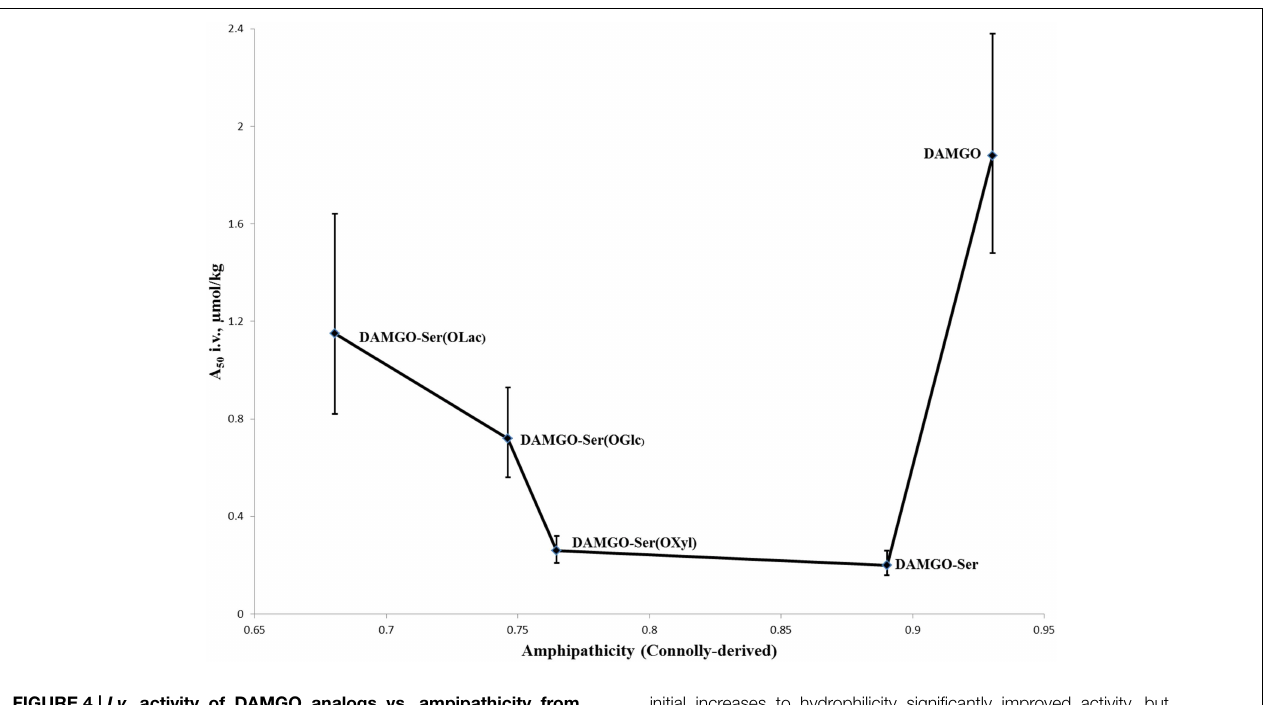
initial increases to hydrophilicity significantly improved activity, but subsequent increases led to a decrease. This is believed to be the result of the peptides spending a preponderance of time in the aqueous phase, providing reduced opportunities for MOR binding and